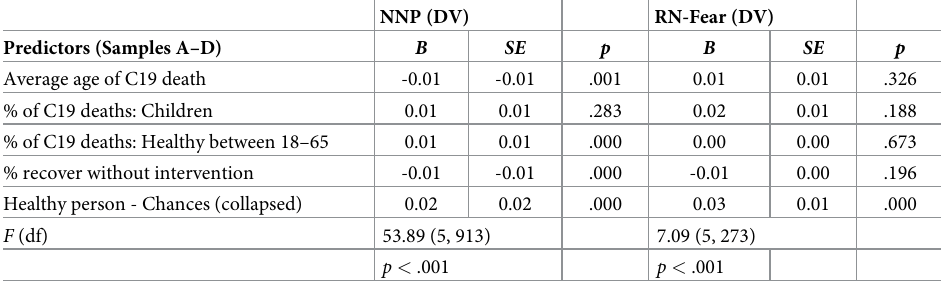
Note . Individual regression analyses by the sample are shown in S6 Table.